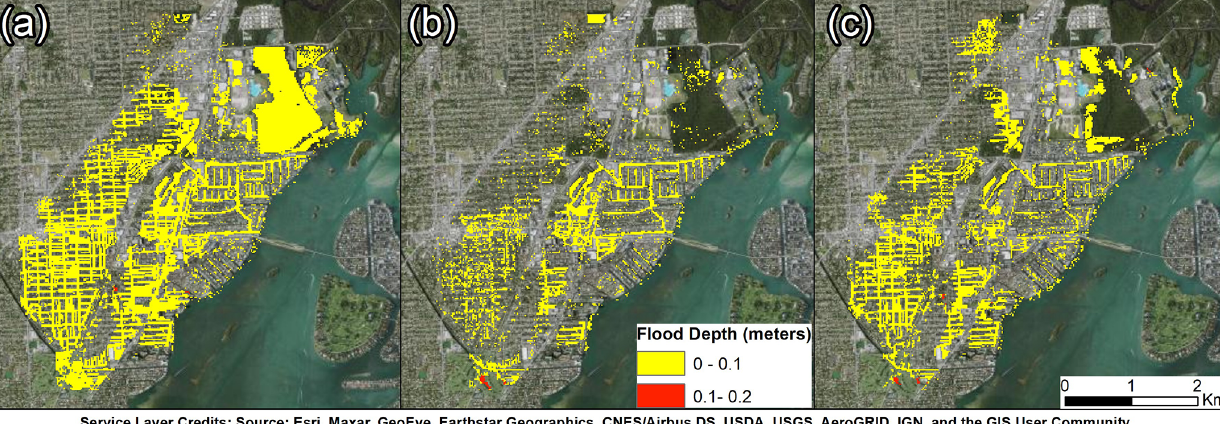
Figure 10. Spatial distribution of groundwater-induced flooding for Tropical Storm Leslie (a) , Tropical Storm Andrea (b) and the 25 May 2020 event (c)